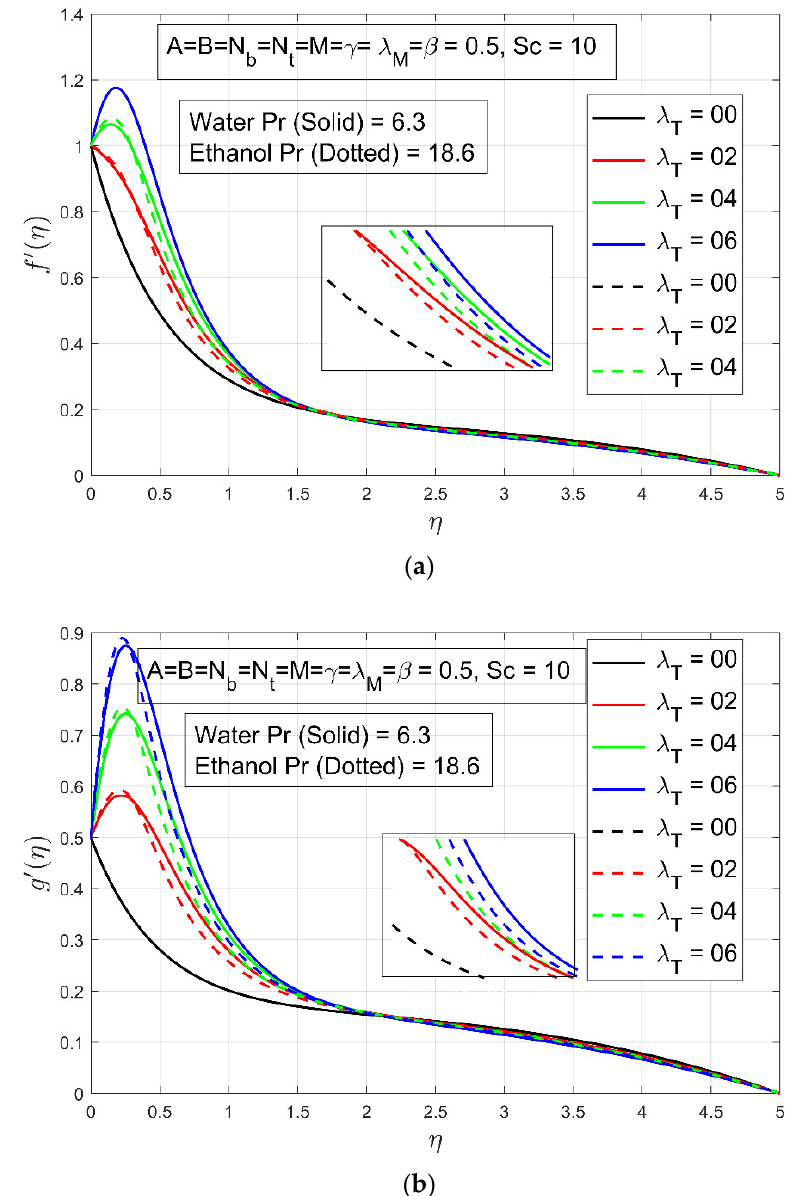
Figure 3. ( a ) The effect of λ T on velocity profile f (cid:48) ( η ) ; ( b ) The effect of λ T on velocity profile g (cid:48) ( η ) .